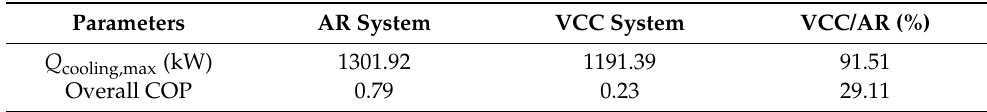
Table 9. Cooling performance comparison between CCHP and AR